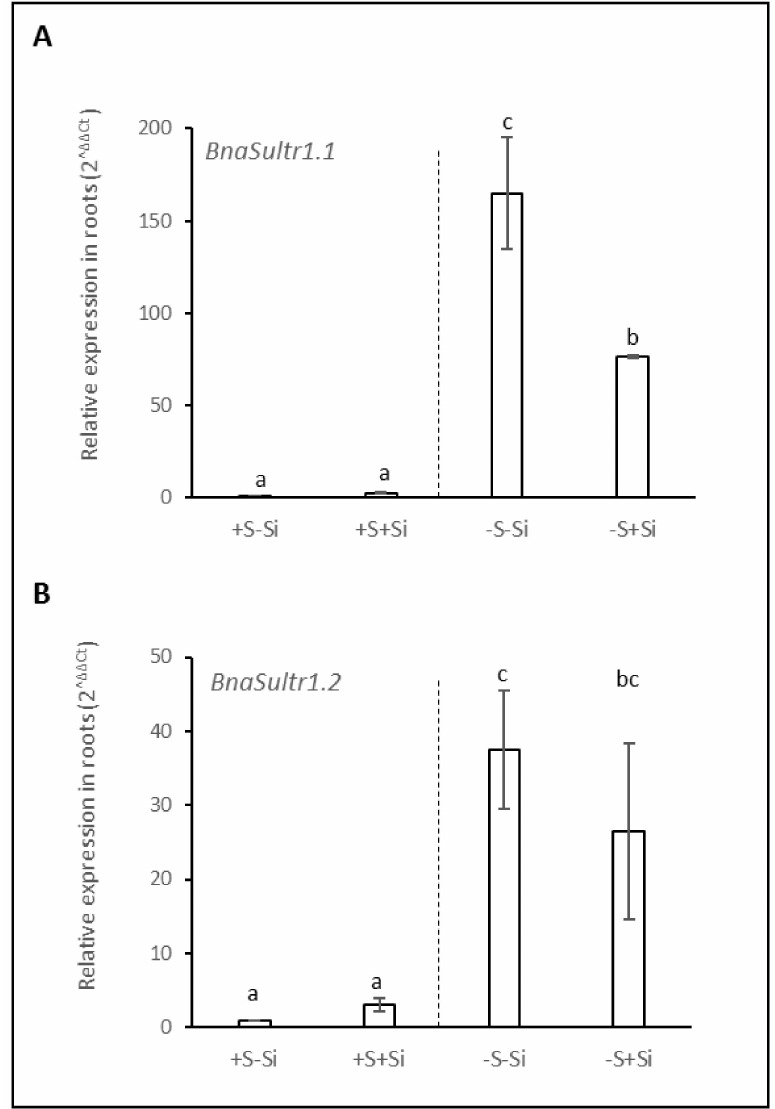
Figure 4. Relative expression of genes encoding the sulfate transporters BnaSultr1.1 ( A ) and BnaSultr1.2 ( B ) in roots of Brassica napus L. cultivated in hydroponic conditions for 21 days with (+S; 500 µ M) or without sulfur (–S; 0 µ M) concentrations and with (+Si; 1.7 mM) or without silicon (–Si) supply. Data are means ± SE (n = 4). Different lowercase letters indicate that means are significantly different ( p <